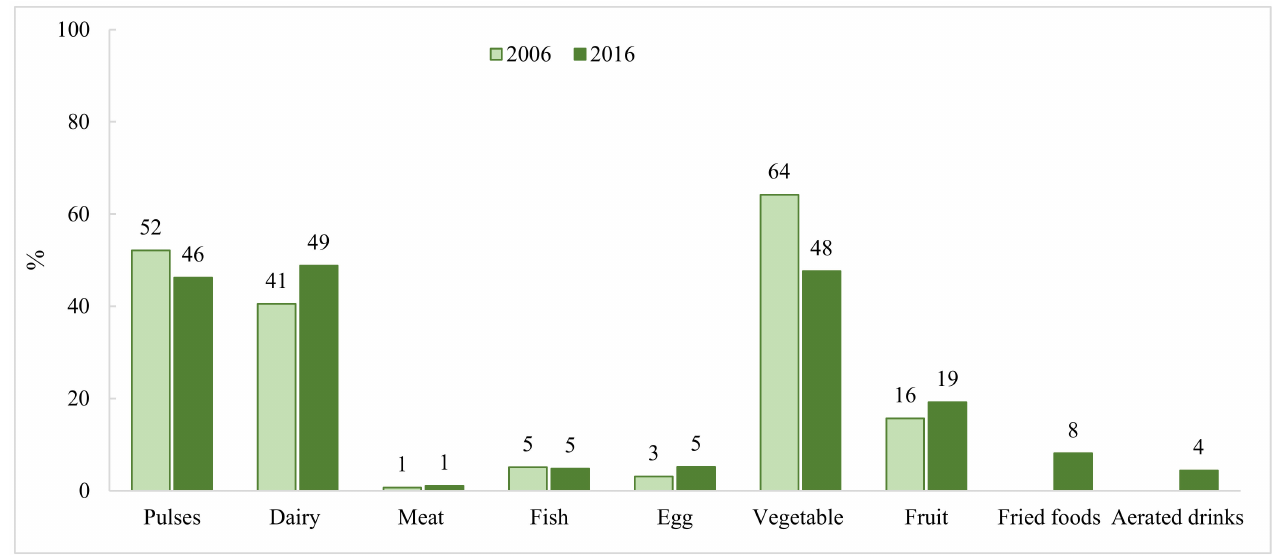
Figure 1. Dietary intake among pregnant women in India between 2006 and 2016 1 . 1 National data comes from National Family Health Surveys in 2005–2006 and